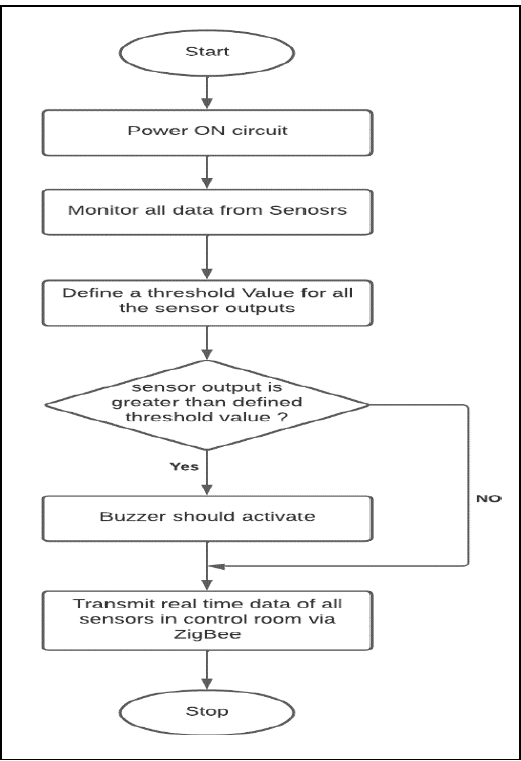
Fig. 3: Flow Chart For Controller